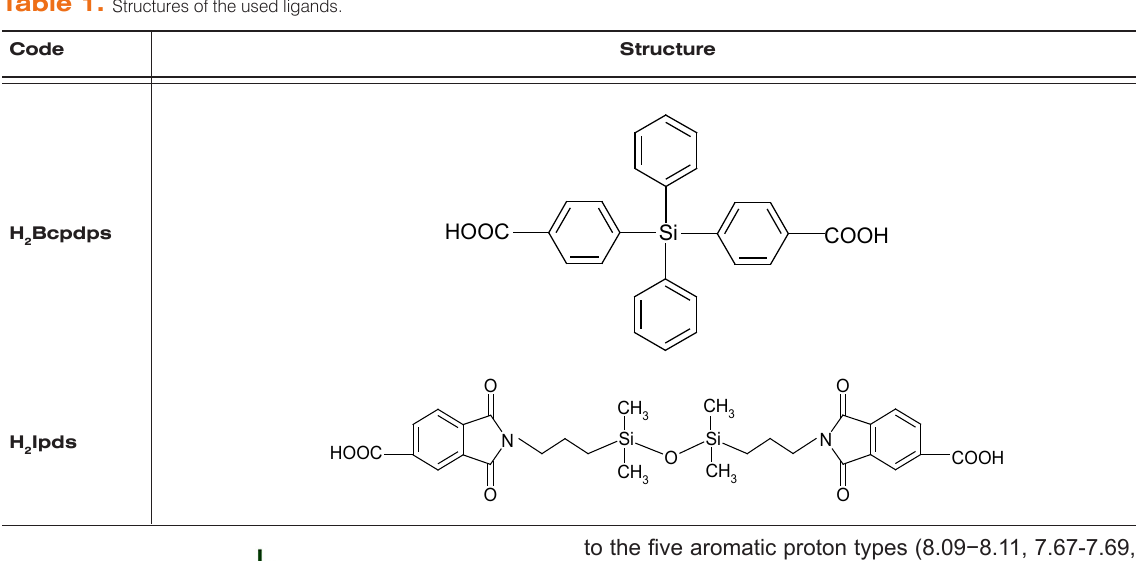
Table 1. Structures of the used ligands.